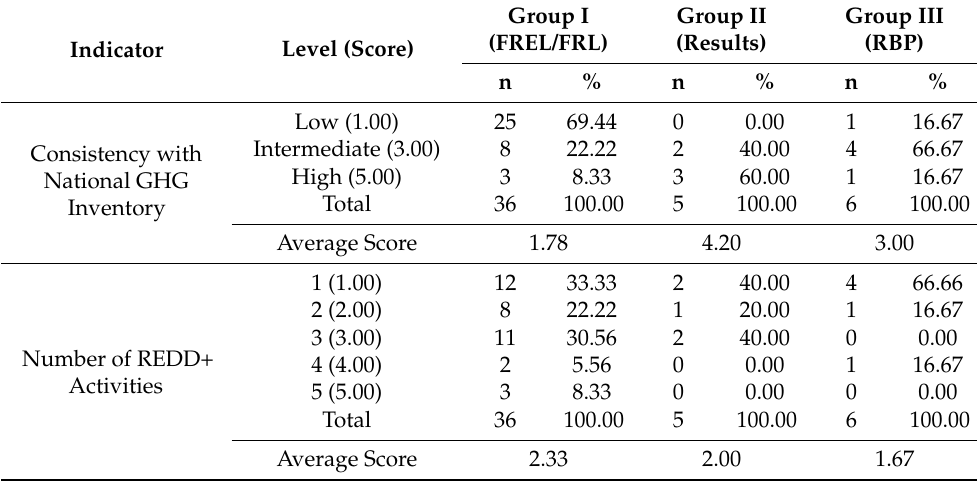
Table 9. Results of MRV capacity evaluation for other items.